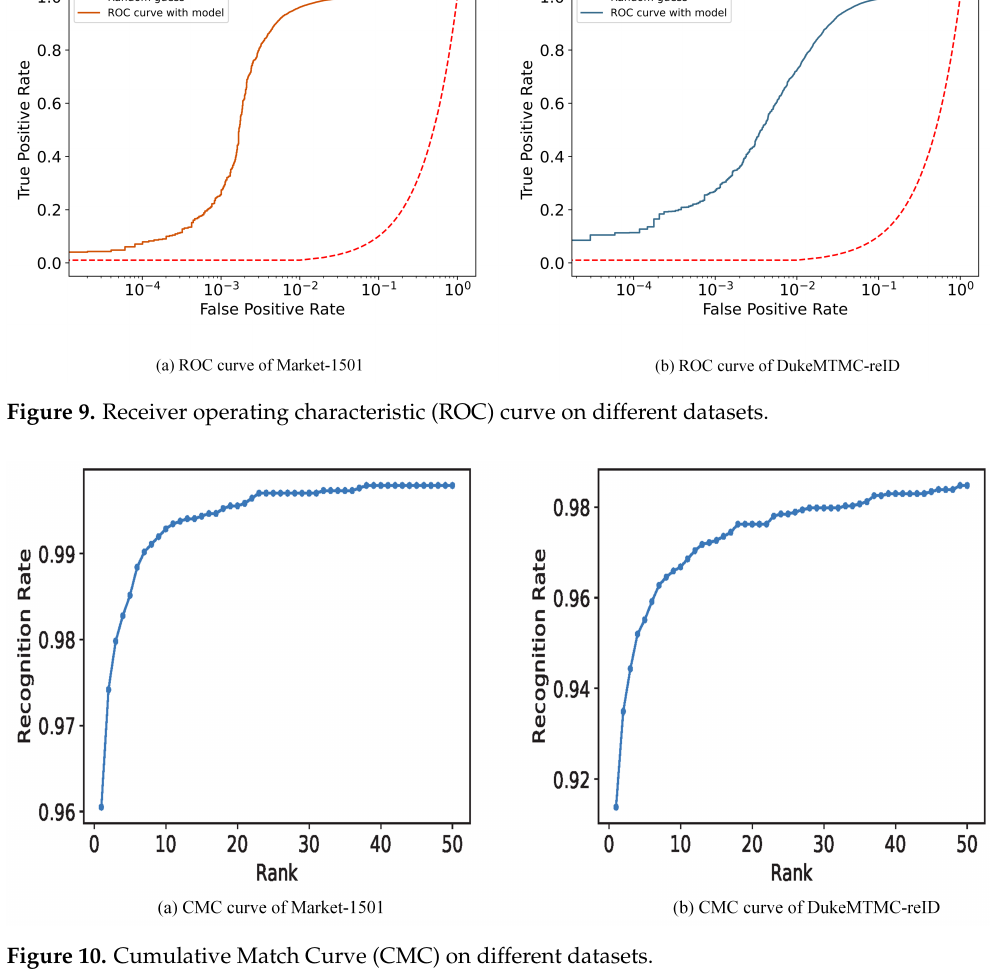
Figure 10. Cumulative Match Curve (CMC) on different